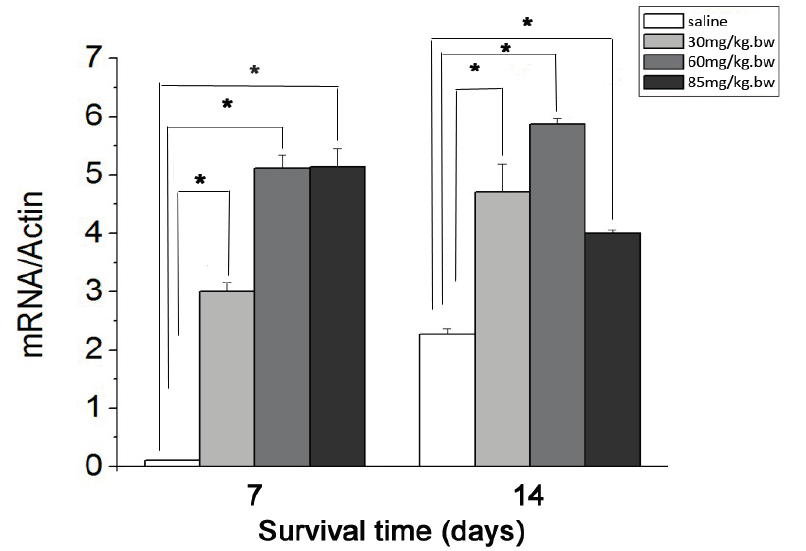
Figure 3. Histogram showing the mRNA levels of brain-derived neurotrophic factor (BDNF) in LiCl and Control groups at 7 and 14 day points. The asterisks indicate significantly higher mRNA levels of BDNF ( * p < 0.01) in LiCl groups compared with those in Control groups ( n = 3 for each dosage and time point) at 7 and 14 day points. Error bars =